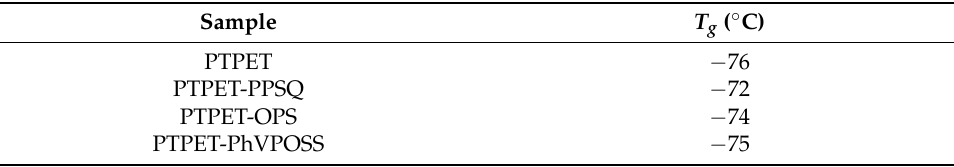
Figure 11. DSC curves of PTPET elastomer and composites. Table 3. DSC data of PTPET elastomer and composites.